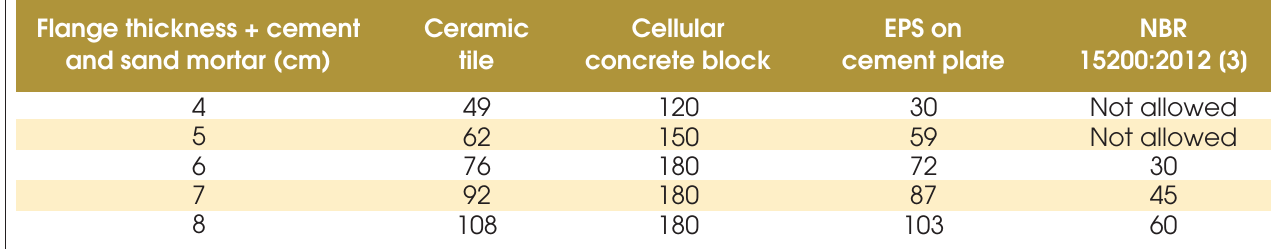
Flange thickness + cement and sand mortar